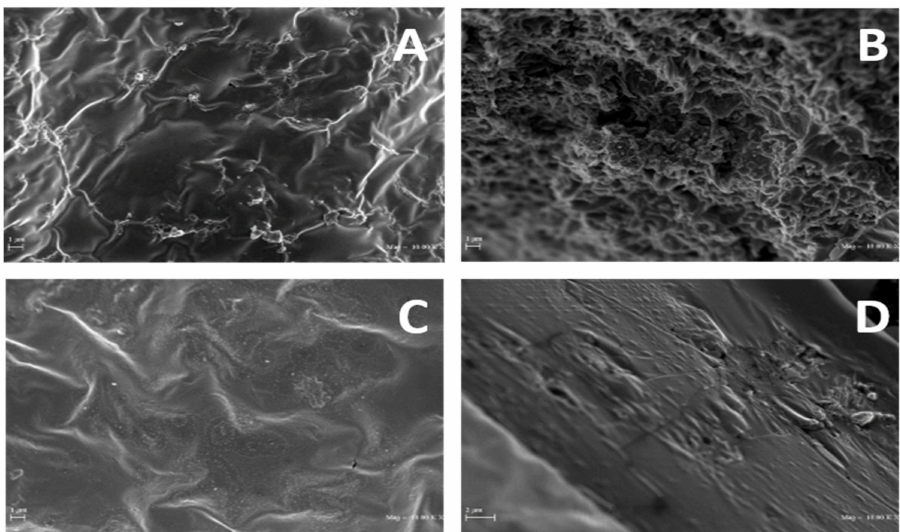
Figure 8. SEM micrographs of PGA films prepared with R1 ( A , B ) and R2 ( C , D ) samples (800 mg) at pH 3.5. The images of the film surfaces ( A , C ) and cross-sections ( B , D ) shown were chosen as the most representative of each sample (10,000 × magnification). Further experimental details are given in the text.